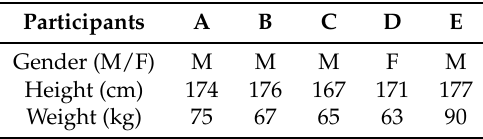
Table 3. Physical condition of the